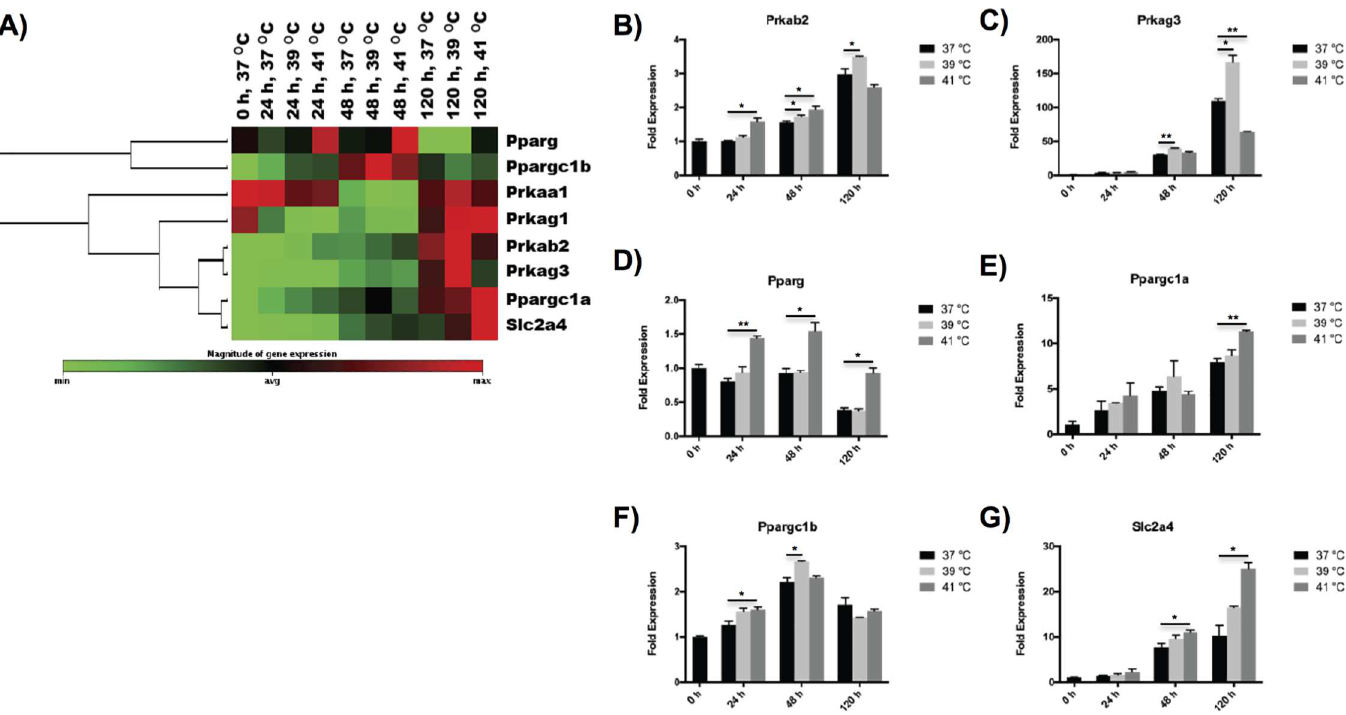
Fig 5. Effects of hyperthermia treatment on mitochondrial biogenesis of C2C12 myoblasts during myogenic differentiation. (A) Clustergram of mitochondrial biogenesisgenes showingtime- and temperature-dependences on hyperthermia treatment during myogenicdifferentiation. (B-G) Characteristic mitochondrial biogenesis genes represented in bar figures. The error bars in (B-G) represent the standard deviationof the mean, and the myotubes cultured at 37˚C were used as a control. All statistical differences against the control are indicated. * p < 0.05, ** p < 0.01, *** p < 0.001.